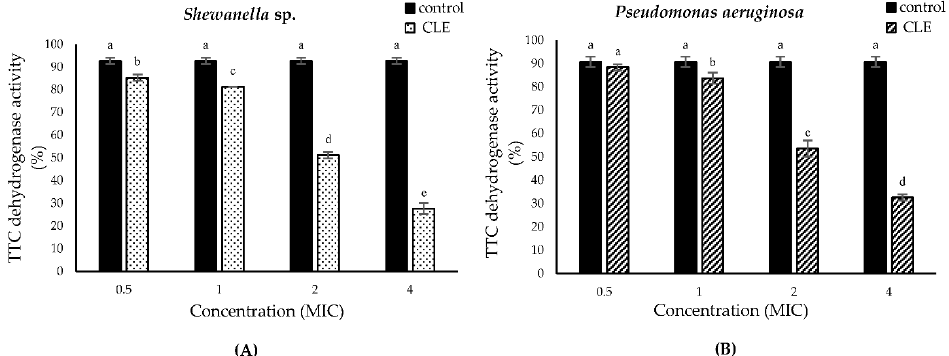
Figure 4. Triphenyl-2H tetrazolium chloride (TTC) dehydrogenase activity of P. aeruginosa (A) and Shewanella sp. (B) without (control) and with CLE treatment at different concentrations. Bar represent standard deviation ( n = 3). Different lowercase letters on the bars denote significant difference ( p < 0.05).